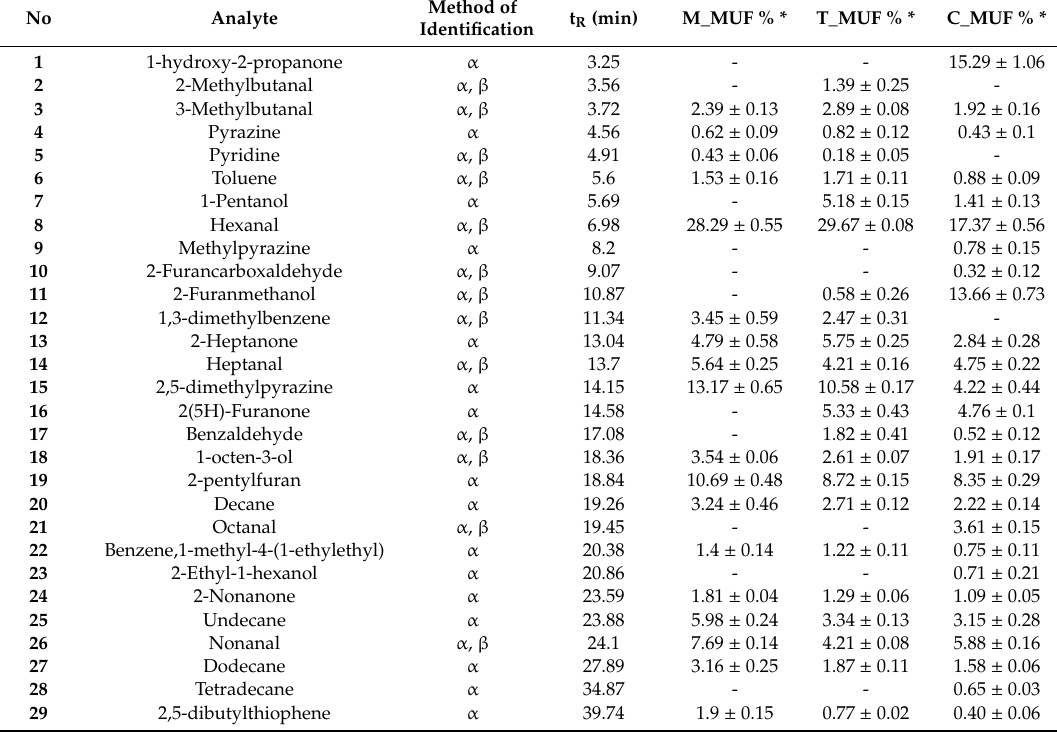
Table 4. Identified volatile compounds and their retention times in three di ff erent mu ffi n formulations. Data represent mean ± SD ( n =